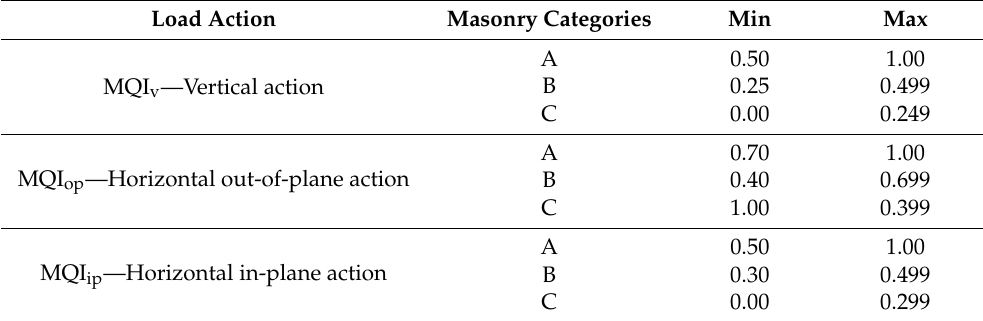
Table 4. Masonry categories and M.Q.I. values. Load